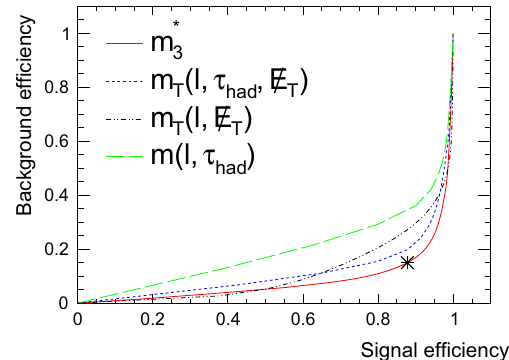
Fig. 5 A comparison of the signal and background efficiencies for cuts on different mass variables in the Z → ττ → (cid:2)τ had candidate event sample. The variable m ((cid:2),τ had ) is defined as the visible mass of the lepton and τ had candidate. The star indicates the position of the proposed cut on m ∗ , which outperforms the other variables over the 3 range of interest